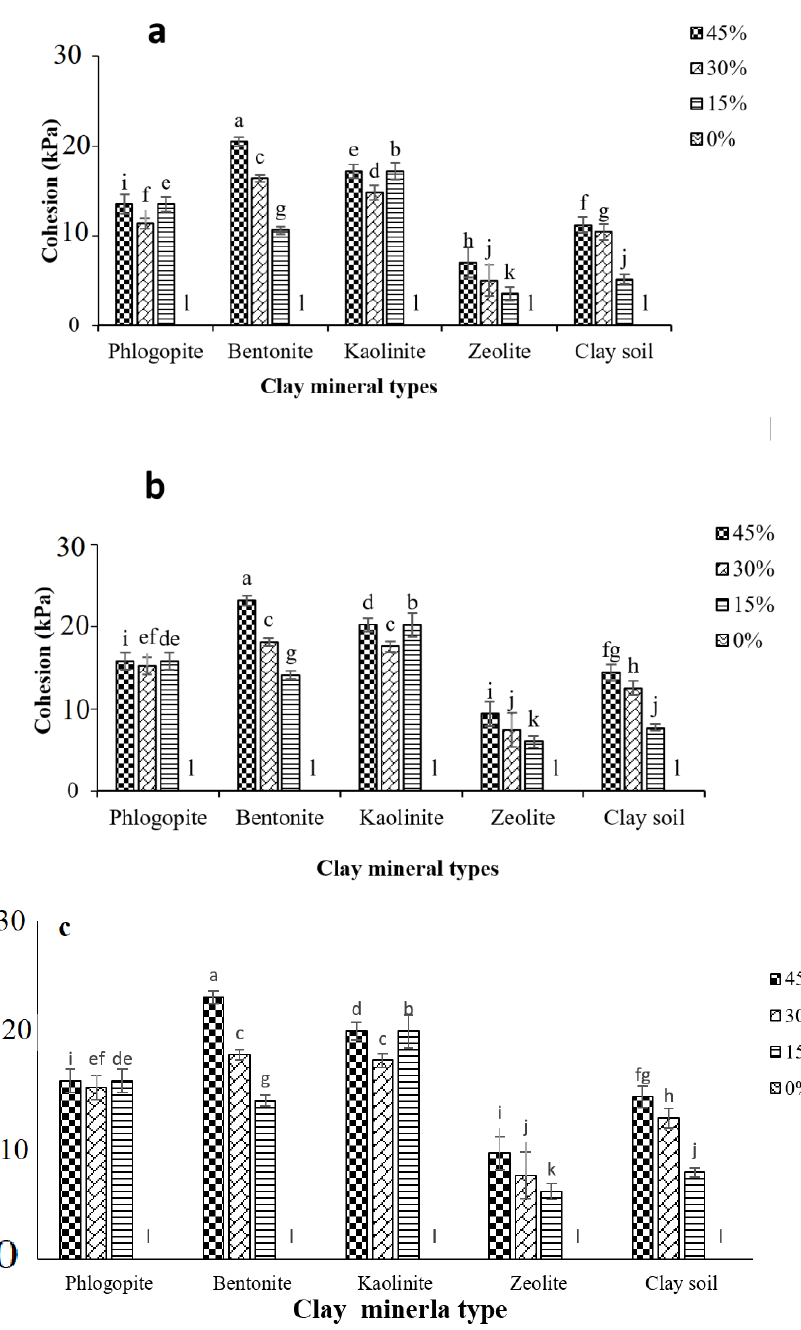
Figure 3. Comparisons of the mean interaction effects of clay type and percentage on the cohesion (kPa) of clay–sand mixtures and clay soil (LSD 0.05 ) without wetting and drying (W&D) cycles ( a ), after one cycle of W&D ( b ), and after two cycles of W&D ( c ). Different letters in the same column indicate significant differences ( p < 0.05) among land uses. For example, two columns labelled with the “c” letter are not statistically different, but columns labelled with the “a” and “b” letters are statistically different ( p < 0.05).